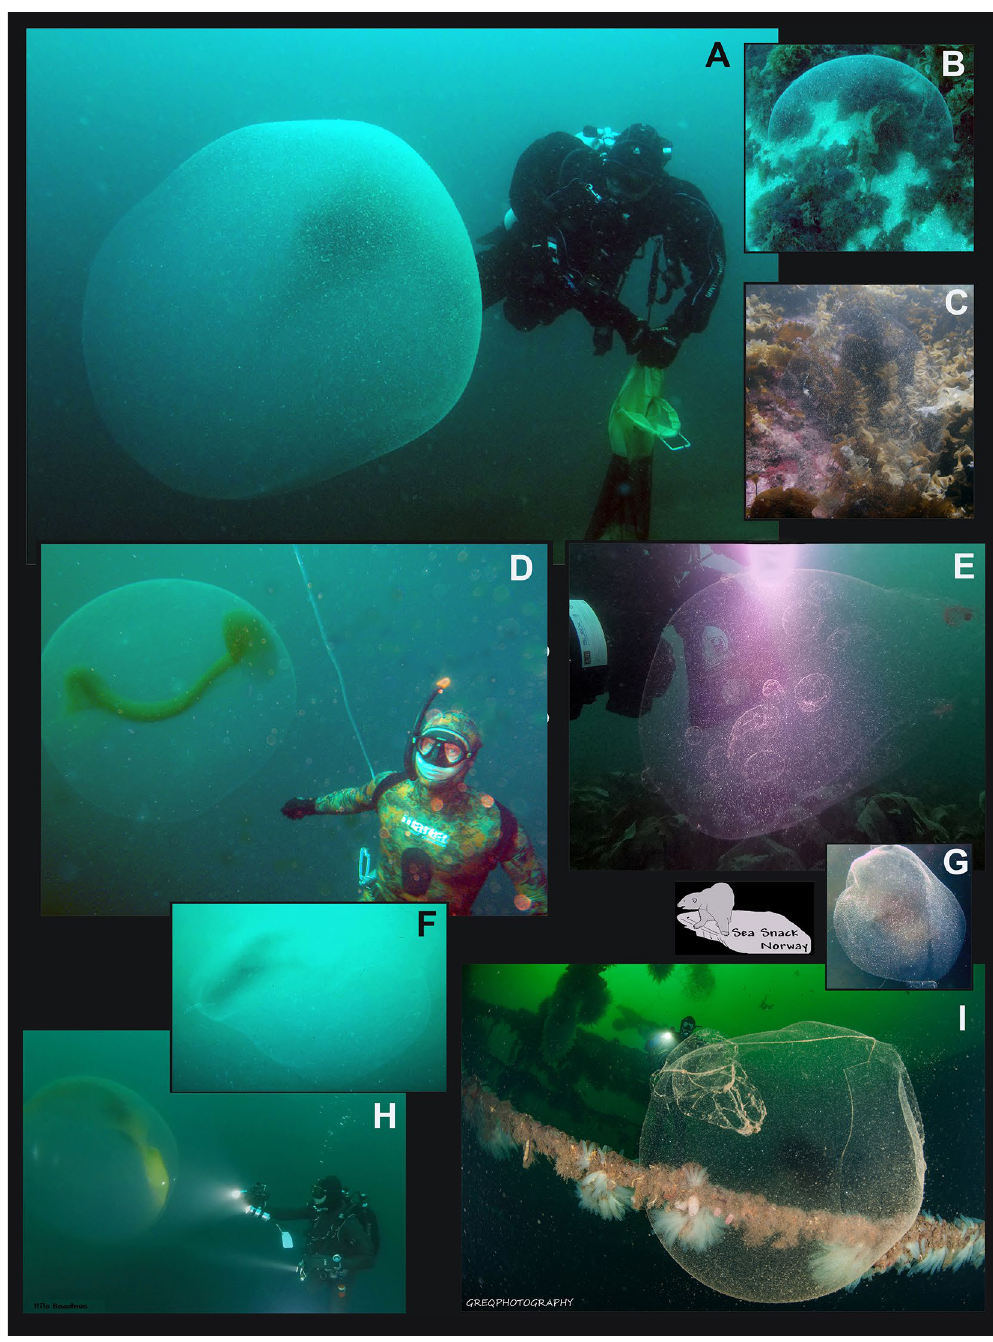
Figure 4. Huge gelatinous spheres from the NE Atlantic Ocean (Norway, Sweden and England) attributed to squid egg mass. (Photo credits: ( A ) Robert Fiksdal, ( B ) Harald Woldsund, ( C ) Birgitta Lantto, ( D ) Tapio Salakari, ( E ) Geir Eliassen, ( F ) Steve Saunders, ( G ) Tor Erik Meland, ( H ) Nils Baadnes, ( I ) Grzegorz Marsicki. Collage by Halldis Ringvold/Sea Snack